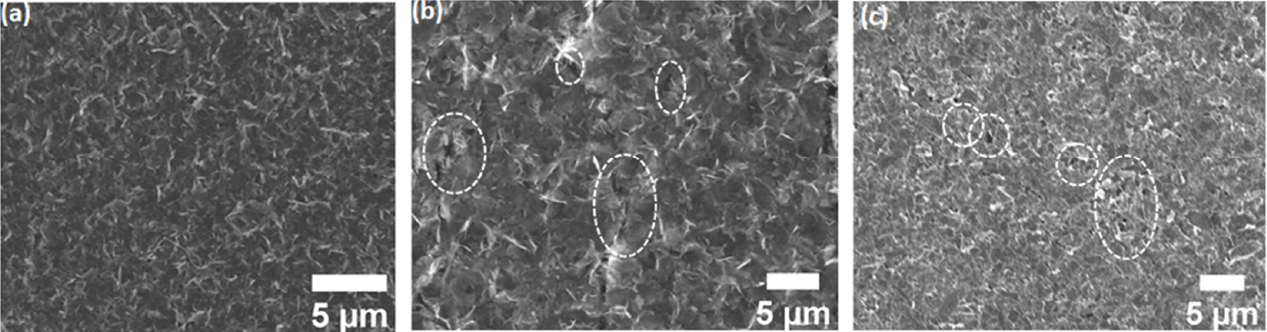
Figure 3. SEM images of ( a ) pristine GNSs, ( b ) functionalized GNSs with Co − Por, and ( c ) functionalized GNSs with Fe − Phc. The observed aggregates on functionalized surface are marked by circles.